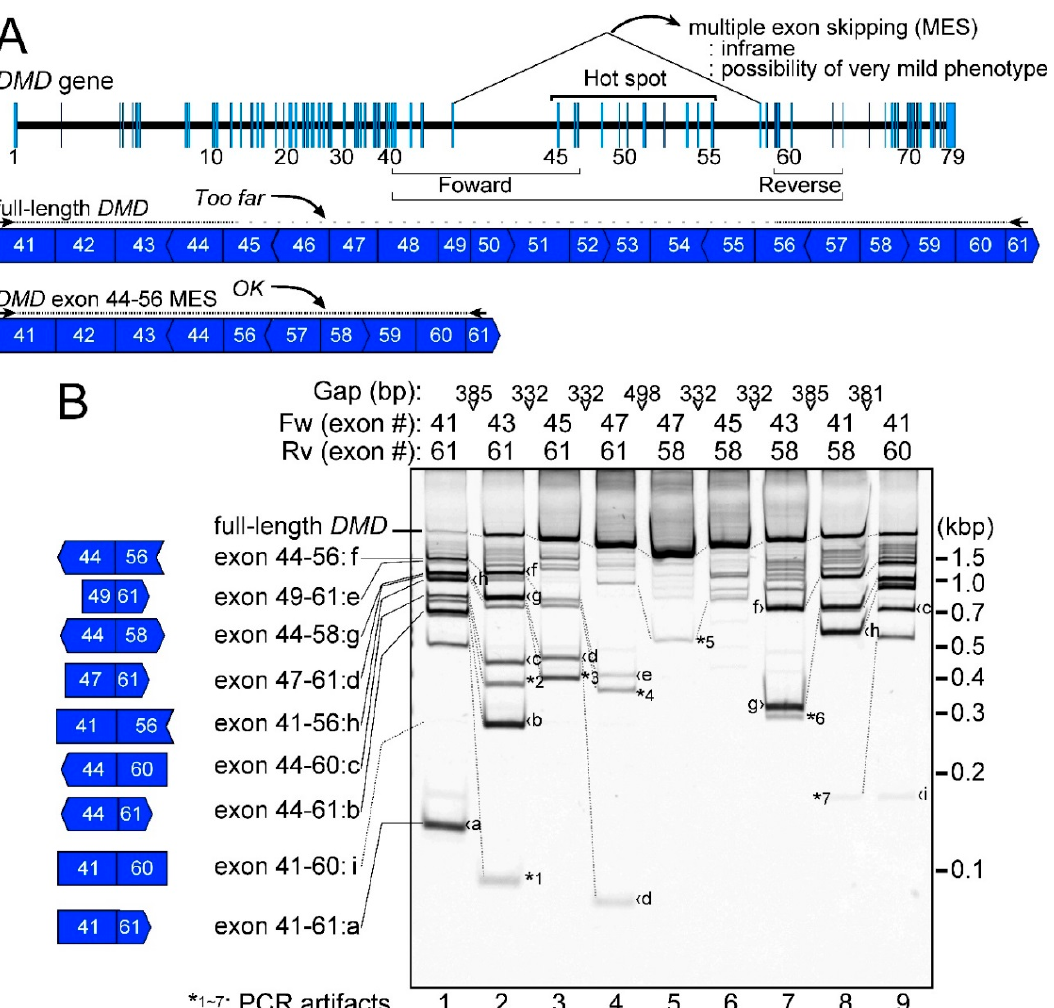
Figure 1. Expression analysis of multiple exon skipping (MES) products. ( A ) A schematic of the Duchenne muscular dystrophy ( DMD ) gene is shown in the upper panel. Nested reverse transcription polymerase chain reaction (RT-PCR) was performed to examine expression of the exon 44–56-connected DMD MES mRNA. Primers were designed upstream or downstream around the DMD hotspot to detect MES mRNAs. The concepts underlying the primer design are also indicated. Vertical ends of exons indicate that ends of exons and codons are matched. Convex ends indicate exons containing +1 nucleotide (nt) for codons, and concave ends indicate exons showing − 1 nt; ( B ) RT-PCR results for MES are shown. Inner primers and the gaps to the next primer are indicated at the top. Molecular markers are indicated on the right side and detected MES products are shown on the left. A schematic of the products on the left side indicates the connecting exons by MES. Broken lines on the panel indicate identical products. Asterisks show PCR artifacts and are explained in Supplementary File 1.